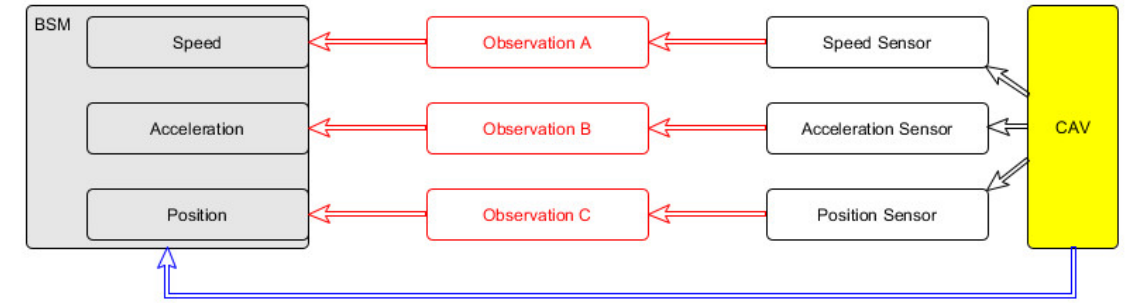
Figure 1. Simplified illustration of translating Basic Safety Message (BSM) data into Sensor, Observation, Sample, and Actuator ontology (SOSA)-based Resource Description Framework (RDF) graph.